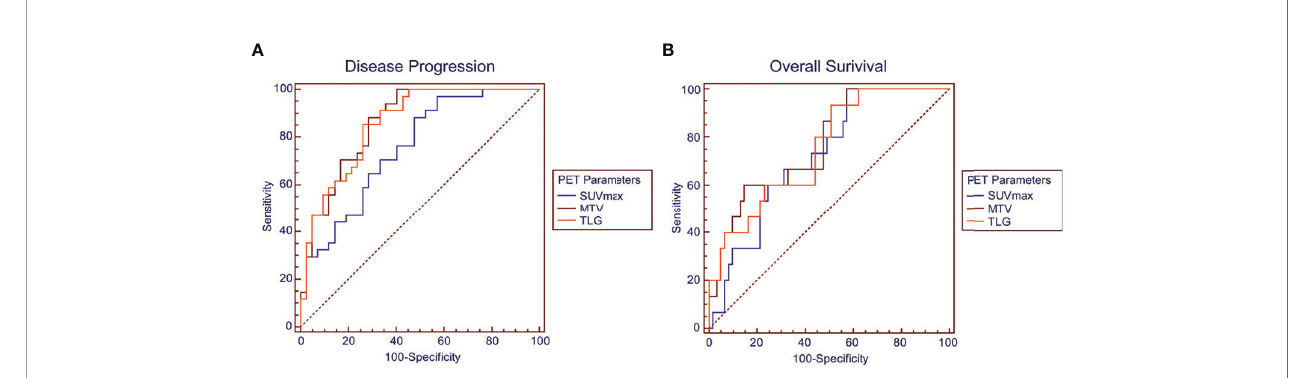
FIGURE 2 | ROC curves showing discriminatory ability of SUVmax, MTV, and TLG for (A) disease progression and (B) overall survival.